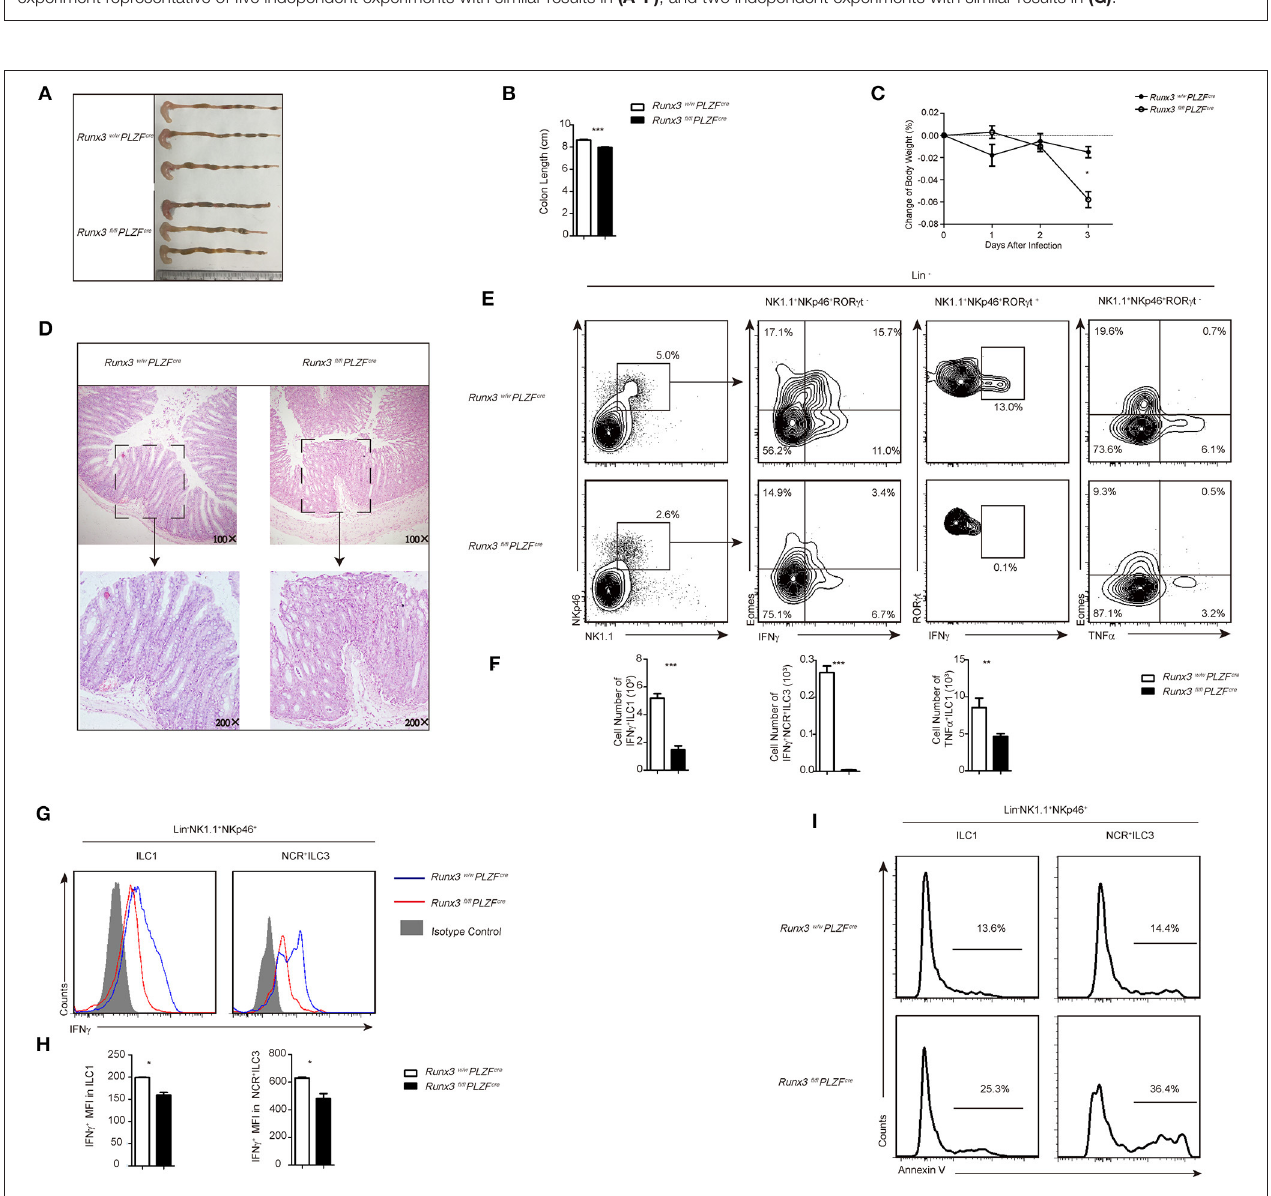
FIGURE 3 | Defective function of ILC1s and NCR + ILC3s resulted in sensitivity to S. typhimurium infection after Runx3 deletion. (A–I) Control and cKO mice were orally infected with S. typhimurium ( n = 6 per group). (A,B) Colon length, (C) change of bodyweight and (D) colon histology stained with haematoxylin and eosin were measured 4 days after oral infection before sacrifice. (E–H) LPL cells isolated from infected wild type or Runx3 KO mice were stimulated and a flow cytometry assay was performed 4h later. (E) Intracellular IFN γ and TNF α in intestinal ILC1s was are the second and fourth line, respectively, and intracellular IFN γ in intestinal NCR + ILC3s is the third line. (F) Absolute cell number of the indicated cell types from wild type or cKO mice in the intestines after infection. (G) A flow cytometry assay was performed and the intracellular IFN γ produced by intestinal ILC1s and NCR + ILC3s was measured. Isotype controls are shaded curves, control groups are blue curves and cKO groups are red curves. (H) Mean fluorescence intensity (MFI) of IFN γ in the indicated cell types. (I) Apoptosis of intestinal ILC1s and NCR + ILC3s labeled with annexin V. (mean ± SD of three samples in (B–D,F,H,I) ; * P < 0.05, ** P < 0.01 and *** P < 0.001 by Student’s t -test). Data are from one experiment representative of five independent experiments with similar results in (A–H)